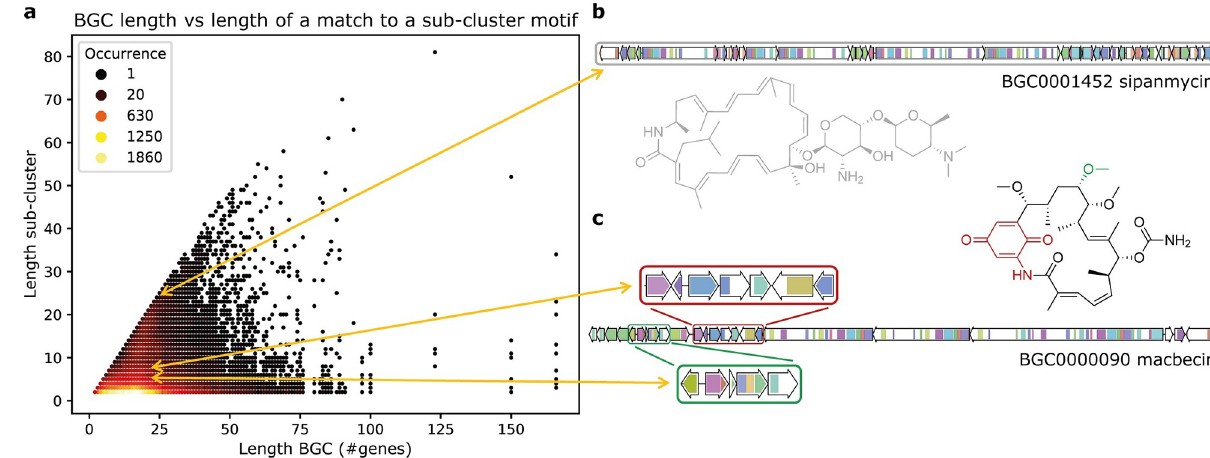
Fig 2. BGC length versus sub-cluster length. (a) Scatterplot of the length of each BGC (number of non-empty genes) from the antiSMASH-DB dataset versus the length of a match to a topic or sub-cluster motif, representing a sub-cluster. The colour of each dot indicates how many times a BGC with a certain length contains a sub-cluster with a certain length. (b) BGC for sipanmycin where the identified sub-cluster encompasses the entire BGC, demonstrating an uninformative result. (c) BGC for macbecin where the two characterised sub-clusters for AHBA (red) and methoxymalonyl (blue) are highlighted in the structure of macbecin [20]. Sub-clusters from (b) and (c) are linked to their corresponding location in (a).